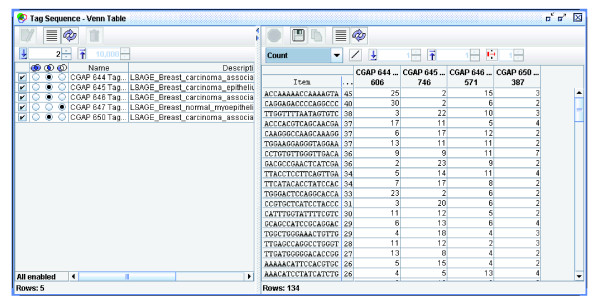
A screenshot of the DiscoverySpace Venn table. In the example above the user has specified five sets of tag sequences from CGAP SAGE libraries and has selected and dragged them into the Venn table. Four of the sets are tag sequences from breast cancer libraries, the fifth, CGAP 647, is from a normal breast sample. The user has raised the quantitative cutoff to 2 or above in order to exclude singleton tag sequences, and has then excluded any tags in the normal set and has selected the intersection of the other cancer sets. The resulting sets of tags are selected from the table and are dragged out for further analysis in the DiscoverySpace Explorer.